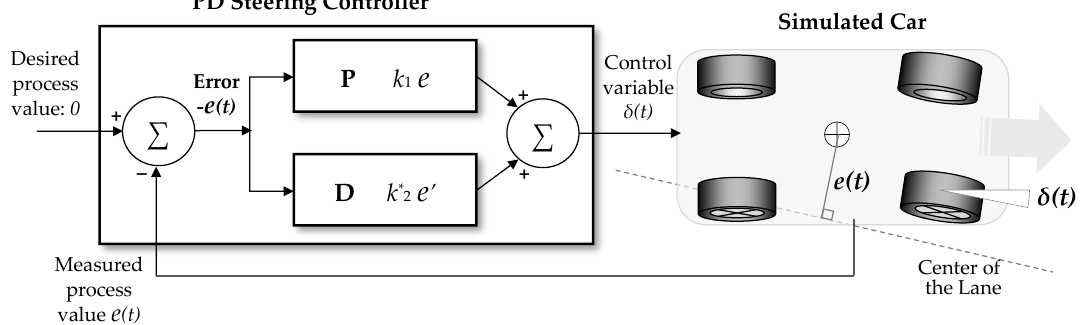
Figure 4. Servo-control model of steering as a proportional-derivative (PD) steering controller. The steering angle function (SAF), defining the steering angle δ , is implemented as the sum of the proportional (P) and derivative (D) terms of the error: the deviation e from the center of the lane.